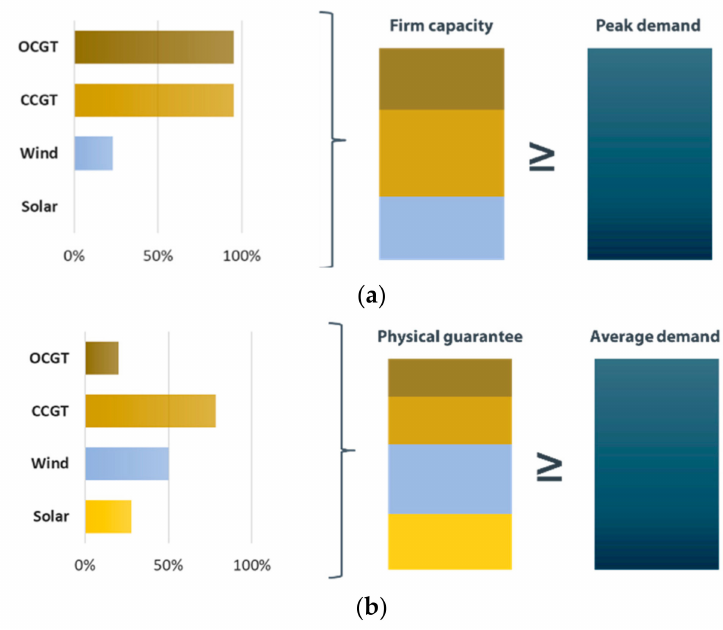
Figure 7. Reliability constraints in Brazil: firm capacity ( a ) and physical guarantee ( b ) criterion.